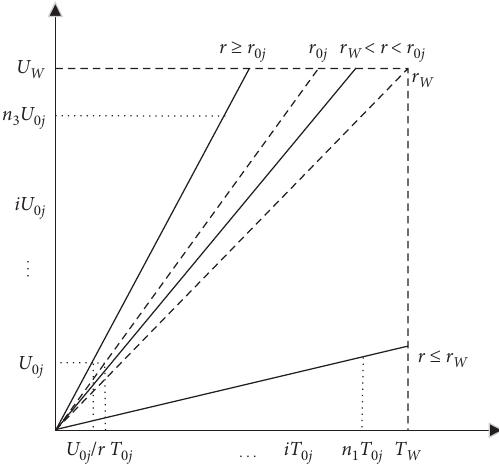
Figure 6: Two-dimensional imperfect PM cycle under r